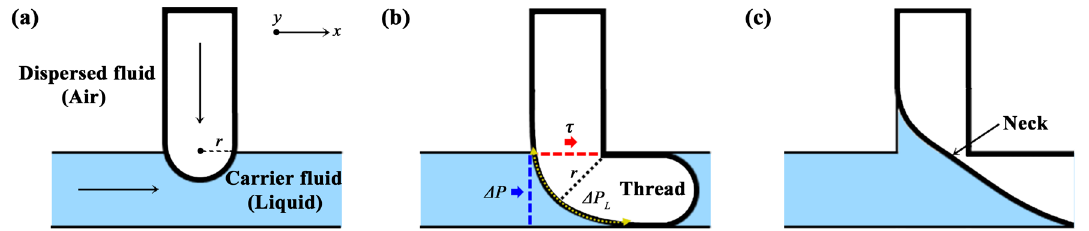
Figure 2. Process of developing segmented flow made up of liquid slugs and air bubbles in T-junction of 3D-printed chip. In this study, liquid in the main channel is considered a carrier fluid and air a dispersed fluid to be squeezed as flowing from 90° channel to main channel. Laplace pressure (Δ P L ), shear stress (τ) and pressure drop (Δ P ) are expressed as yellow dotted, red and blue arrows. The formation of the liquid slug and air bubble was illustrated by the authors using Adobe Photoshop 2021 (Adobe Inc.,